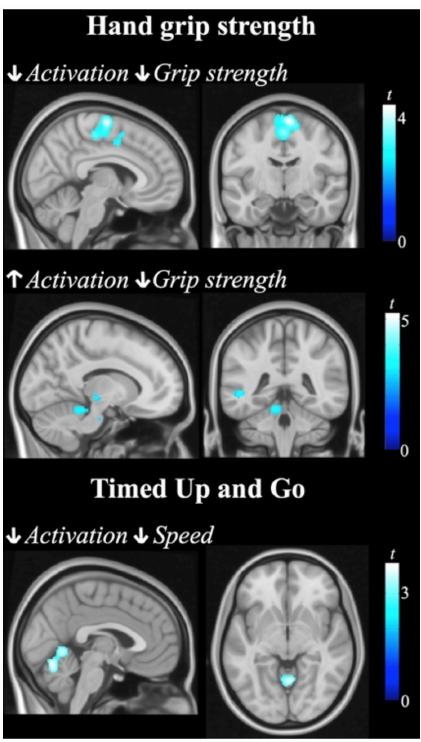
Figure 4. Correlation between brain activation and behavior scores. Significant interactions between group and correlation pattern are reported. Individuals with Prader Willi syndrome showed a stronger (than controls) positive association between activation in the supplementary motor area and hand grip strength (top row), stronger negative association between activation in the cerebellum and hand grip strength (mid row), and weaker association between activation in the cerebellar vermis and score in the Timed Up and Go test (bottom row). Color bars represent t values. Right in coronal views corresponds to the right